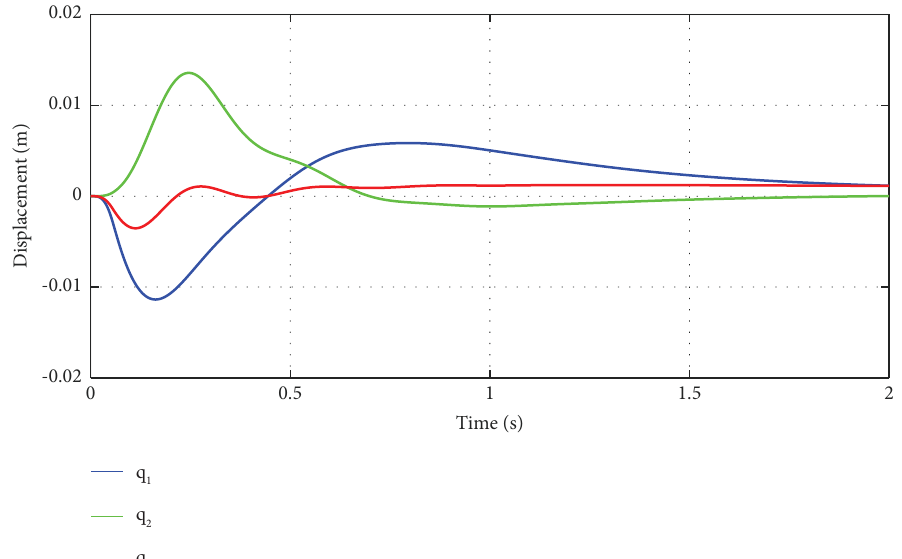
Figure 3: Displacements of parts of mobile antiaircraft weapon system after launch at the angle of attack α unsprung mass m 1 of the front suspension, q 2 -vertical displacement of unsprung mass m 2 of the rear suspension, and q 3 -vertical dis- placement of mass center of the vehicle